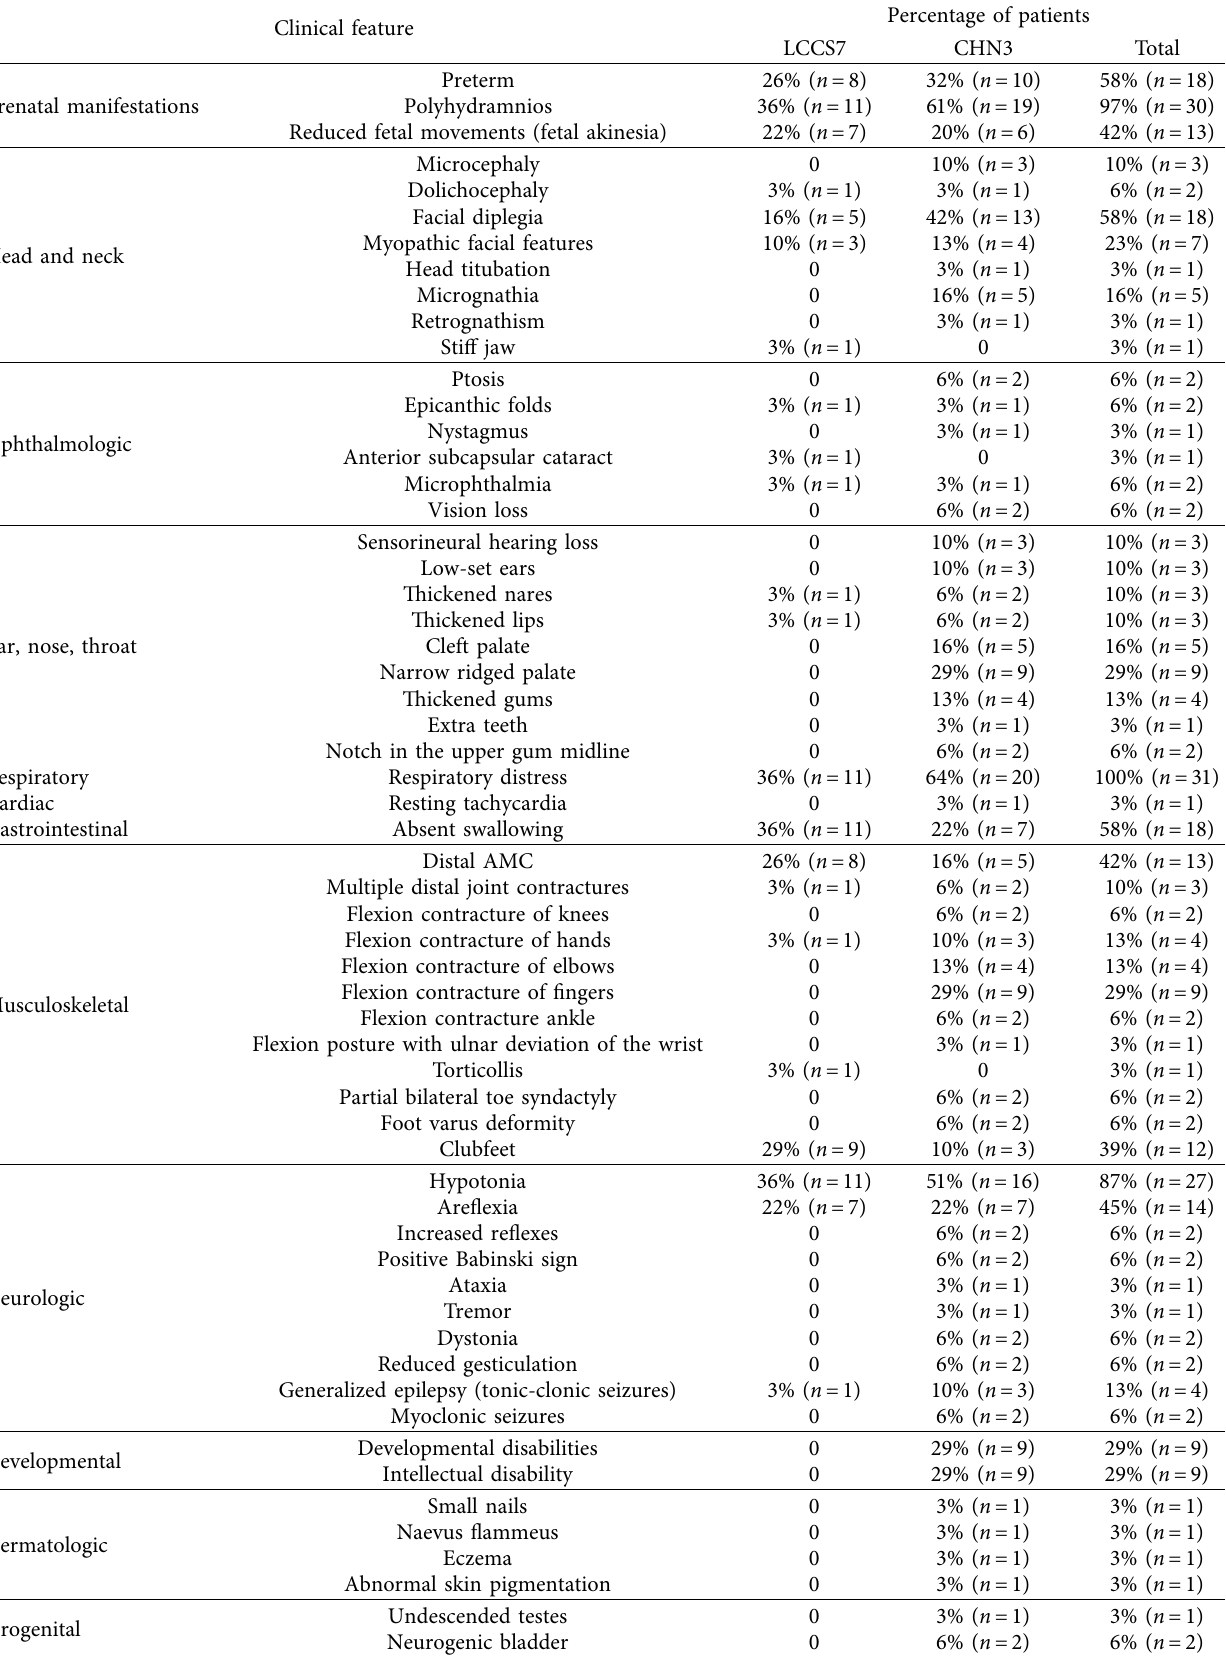
Table 1: Review of clinical features associated with LCCS7 and